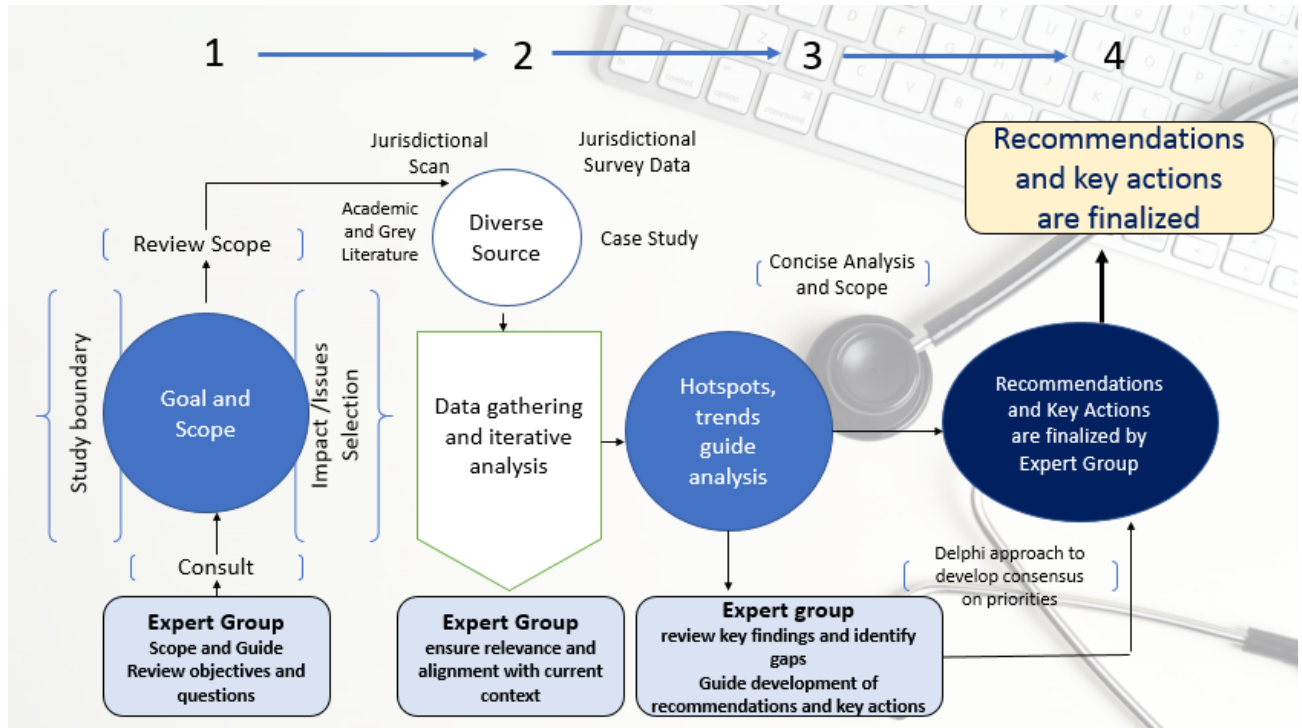
Figure 1: Mixed methods approach (adapted from Barthel et al.,